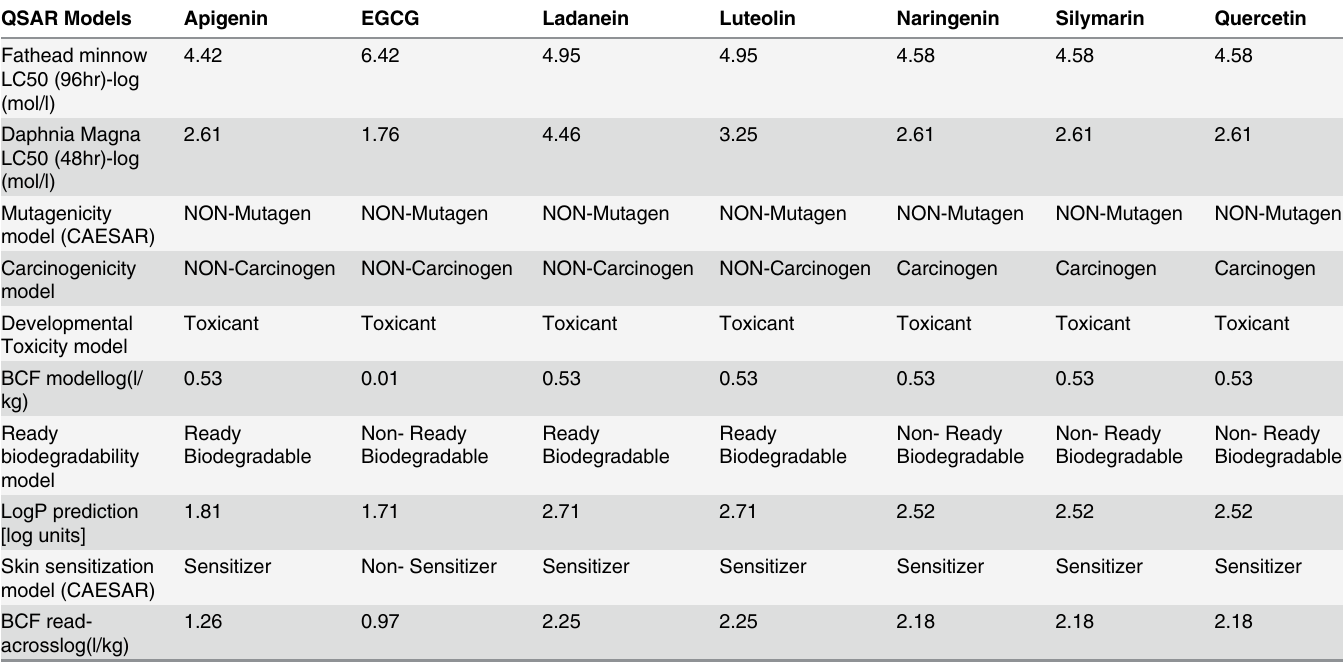
Table 5. QSAR predicted values and their applicability domain analysis for various models for active flavonoids. QSAR Models